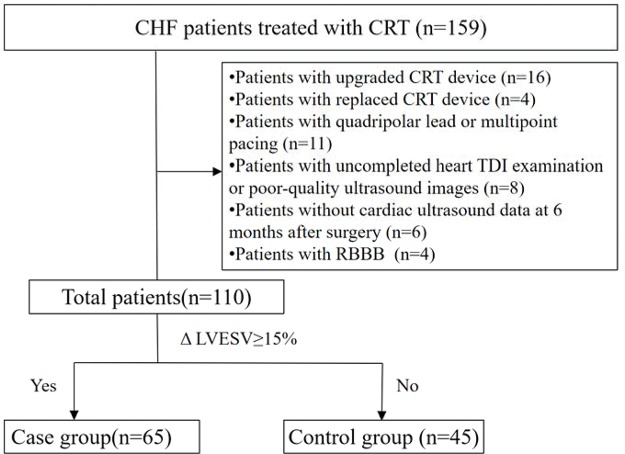
Study flow diagram.